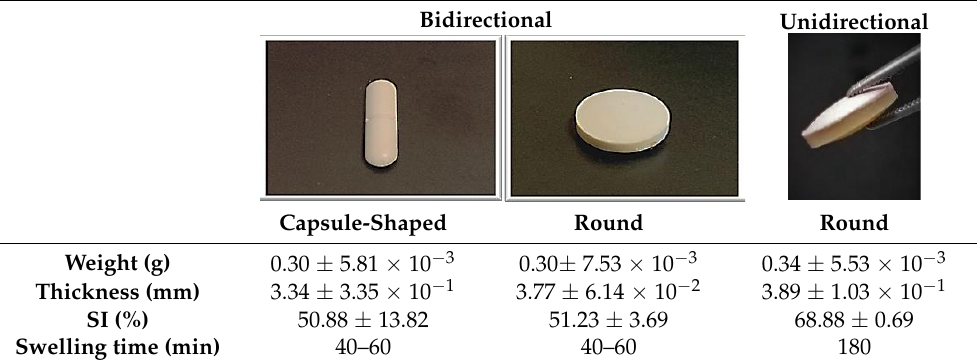
Table 2. Characteristics of capsule-shaped and round tables produced from lyophilized cakes. n = 20 weight, n = 10 thickness and n = 3 swelling index and time.